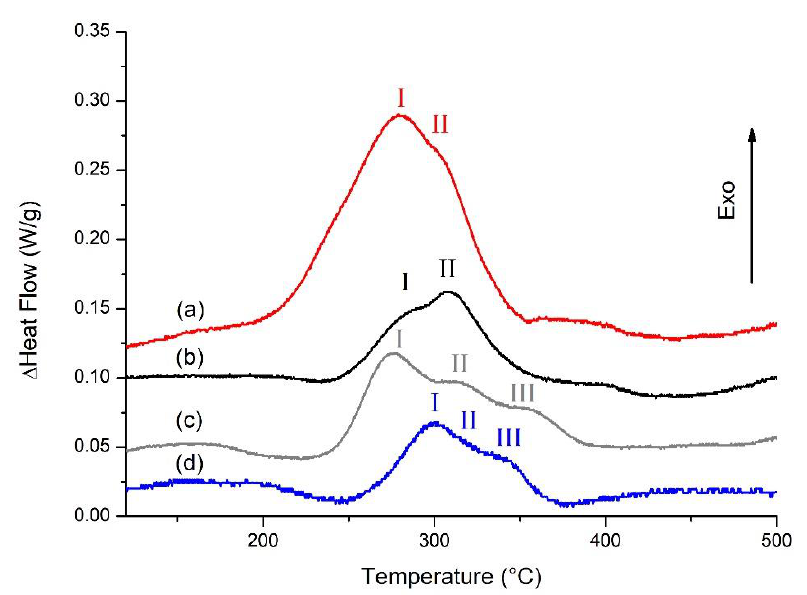
Figure 5. DSC curves of F357 samples in the ( a ) AB, ( b ) DA-6, ( c ) S-SHT, and ( d ) S-T6-6 conditions. Peaks I, II, and III are referred to as Si, Mg 2 Si, and iron phases precipitation, respectively.